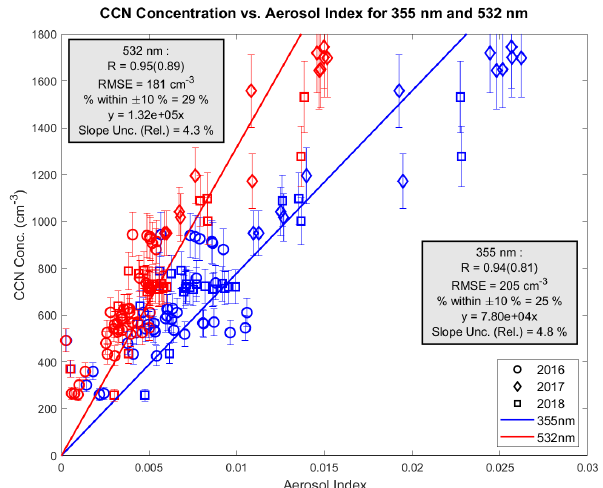
Figure 4. CCN concentration versus aerosol index is given for the combined 3-year data set. Blue scatter points show results calcu- lated using extinction at 355nm, and red scatter points show results calculated using extinction at 532nm. Supersaturation for these ob- servations ranges between 0.22%–0.4%. The Pearson correlation coefficient is shown, with the Spearman rank correlation coefficient given in parentheses. Error bars are given for a CCN relative uncer- tainty of 10%. Uncertainty for the aerosol index is not given due to the nature of the extinction and Ångström exponent not being inde- pendent of each other, as required for error propagation equations. Lines of best fit are forced through the origin to represent the prac- ticality of using linear regression equations to quantitatively obtain CCN concentrations using HSRL-2